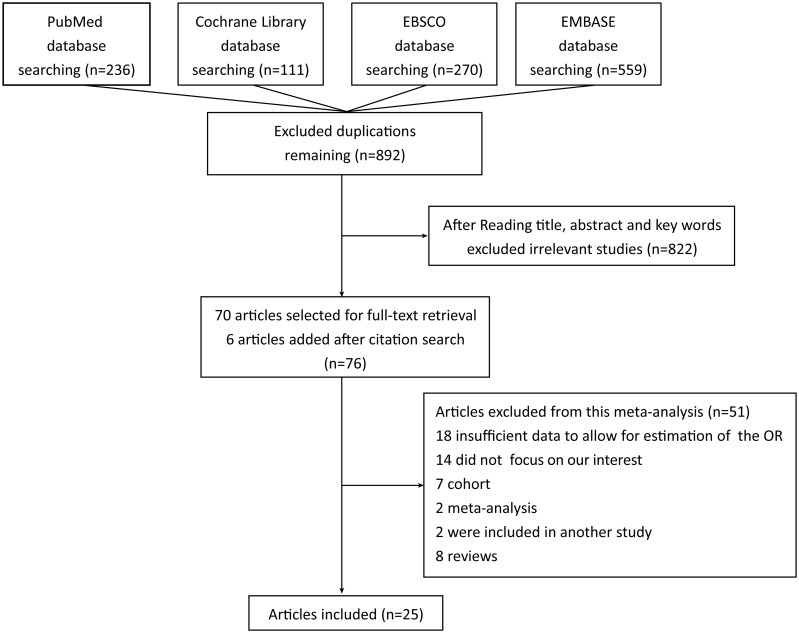
A flowchart of the study selection process.